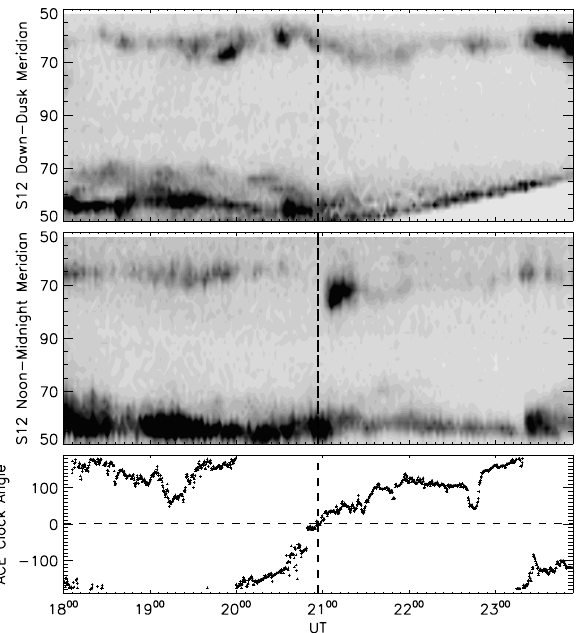
Fig. 4. Dawn-dusk and noon-midnight keograms of the SI12 data during the interval of interest, 18:00 to 24:00 UT on 21 October 2001. In the first panel dawn is at the top and dusk at the bottom, in the second, noon is at the top and midnight at the bottom. These demonstrate that the auroral oval expands and contracts throughout the interval. Below this is the clock angle measured by ACE with the vertical dashed line representing the time at which the clock angle passed through zero.